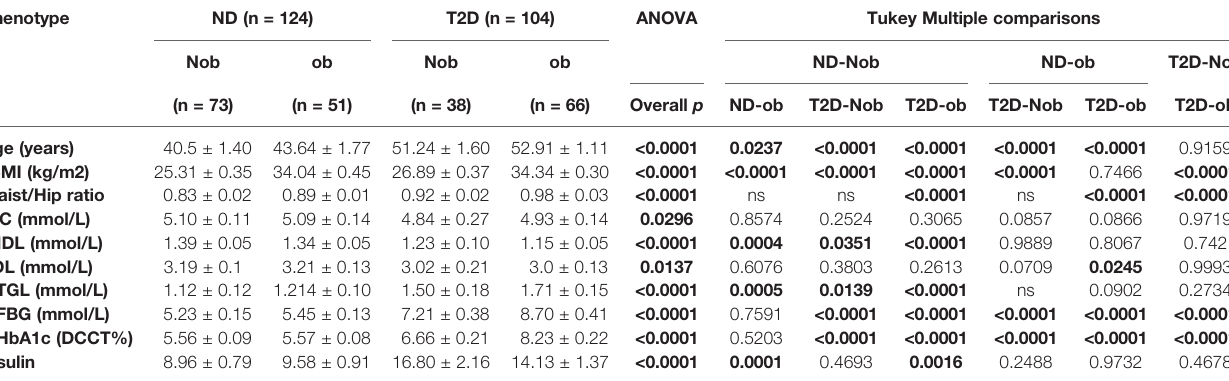
TABLE 1 | Physical and biochemical characteristics of the population characterized into 4 groups: non-diabetic non obese (ND-Nob), non-diabetic obese (ND-ob), type 2 diabetes non obese (T2D-Nob) and type 2 diabetes obese (T2D-ob).